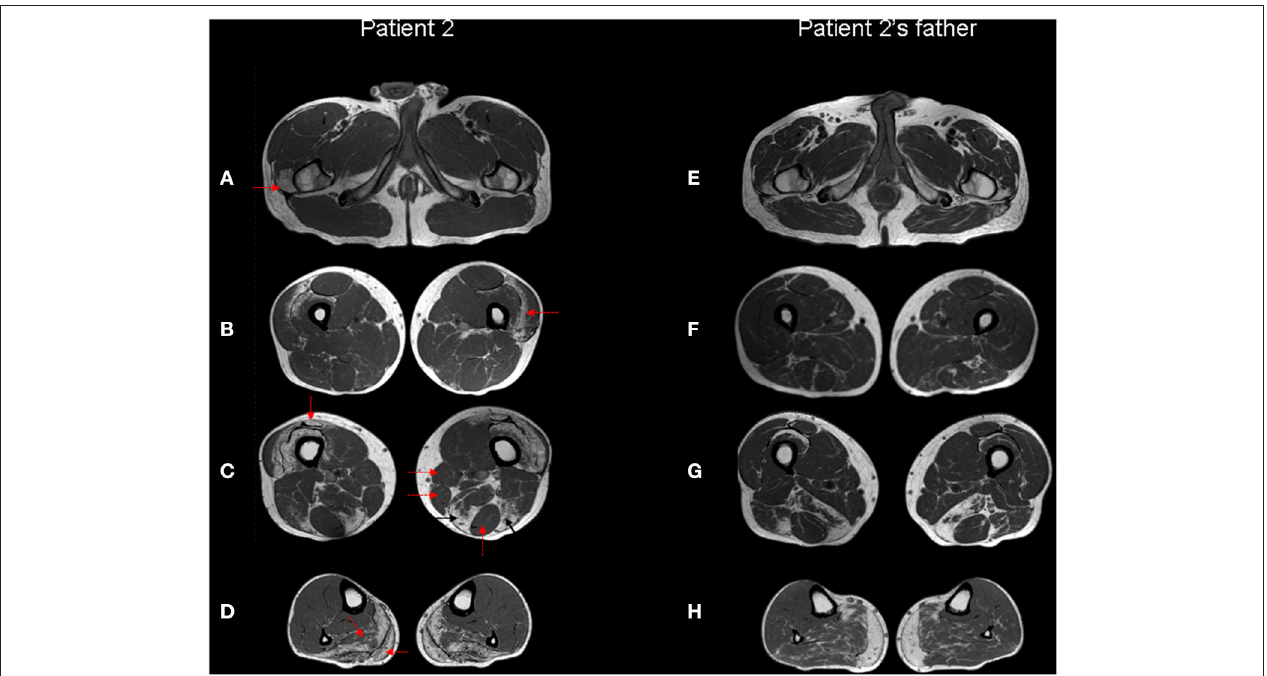
FIGURE 4 | Muscle MRI. Patient 2 (A–D) and patient 2’s father (E–H) Turbo Spin Echo (TSE) axial T1 MRI images from thigh (A–C, E–G) to leg (D,H) . The patient’s images show bilateral symmetric selective fatty degeneration of the distal insertion of the gluteus medius muscle [ (A) , red arrow], subfascial fatty degeneration of vastus lateralis and intermedius muscles [ (B) , red dotted arrow], with a relative sparing of rectus femoris, involved only at the distal insertion [ (C) , red arrow]; fatty degeneration and wasting of semimembranosus and long head of biceps femoris muscle [ (C) , black arrows] with relative preservation of gracilis, sartorious and semitendinosus muscles [ (C) , red dotted arrows]. In the lower leg, there is a predominant fibroadipose replacement of the posterior muscles, primarily affecting the soleus and the medial gastrocnemius muscles [ (D) , red dotted arrows]. The same involvement pattern of selected muscle groups can also be observed in the patient’s father, although it is less pronounced except at the level of the distal